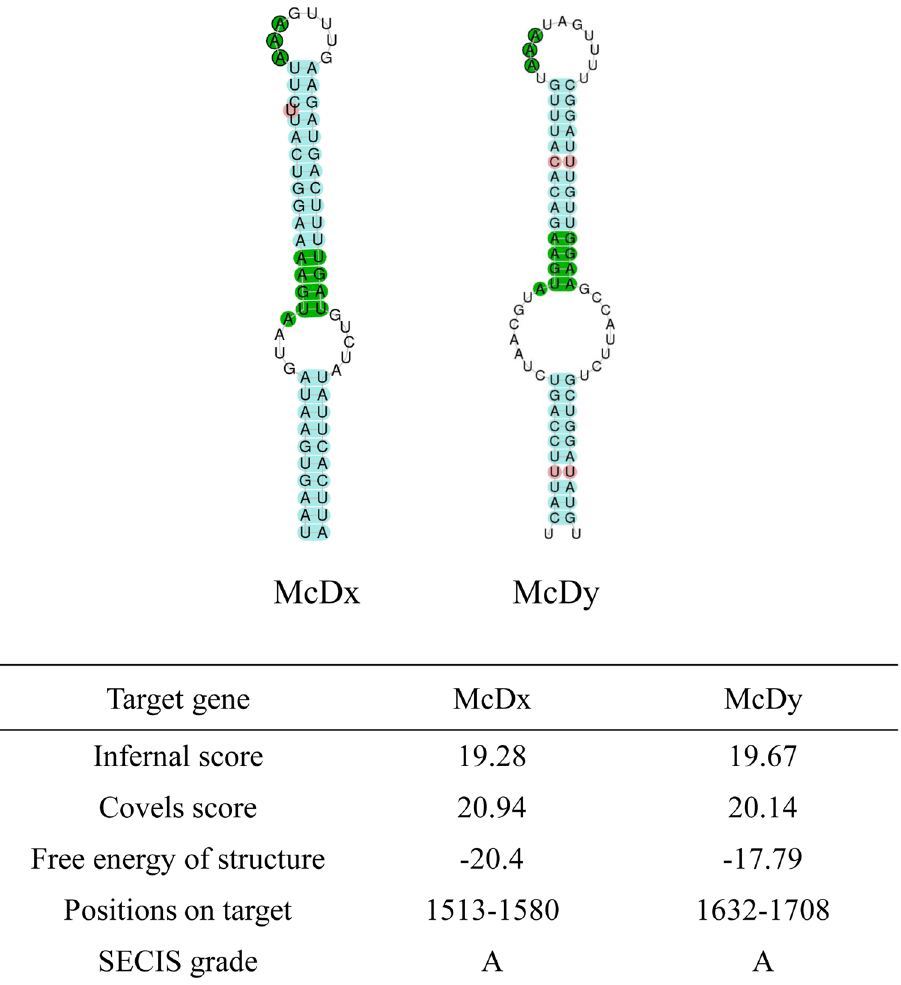
Figure 2. The SECIS elements of two deiodinase genes of M. coruscus were generated by SECISearch3 (Mariotti et al. 2013). The core and the unpaired conserved nucleotides are presented in green, and mismatches are indicated in